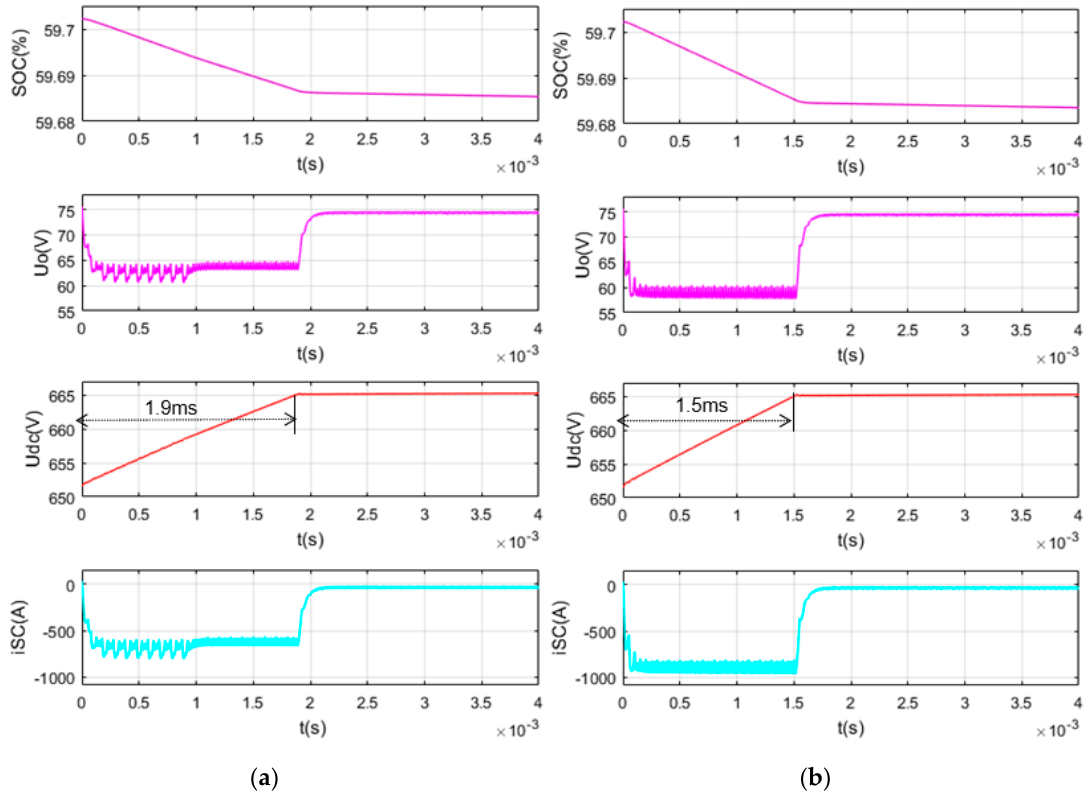
Figure 7. Simulation waveform diagram when the initial voltage, U dc , is 651.7 V and the initial voltage, U o , is 75 V: ( a ) MPC only for the DAB; ( b ) MPC for the DAB-SC system.